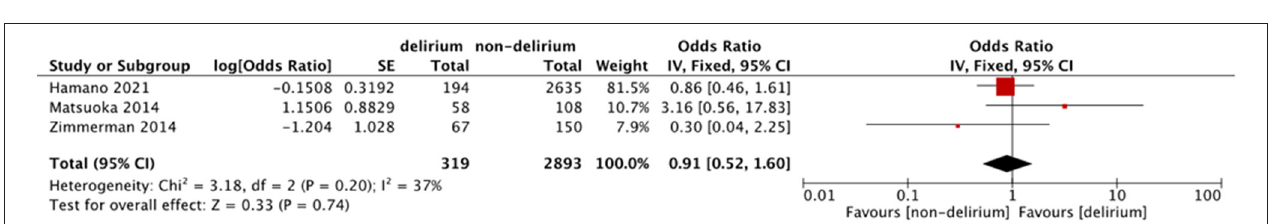
FIGURE 3 | Sensitive analysis of tumor of central nervous